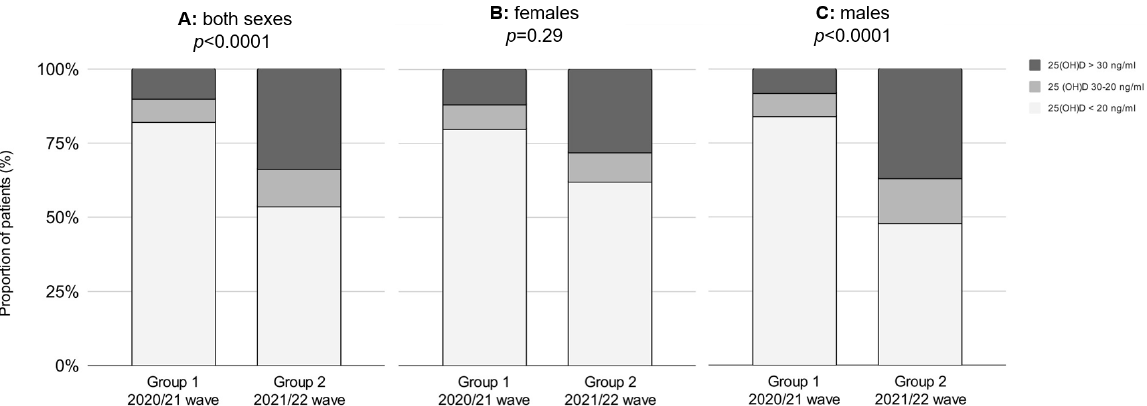
Figure 1. The proportion of patients regarding 25(OH)D cutoff values between the waves in both sexes ( A ), females ( B ) and males ( C ), respectively. Group 1—second wave (2020/21); Group 2—third wave (2021/22).